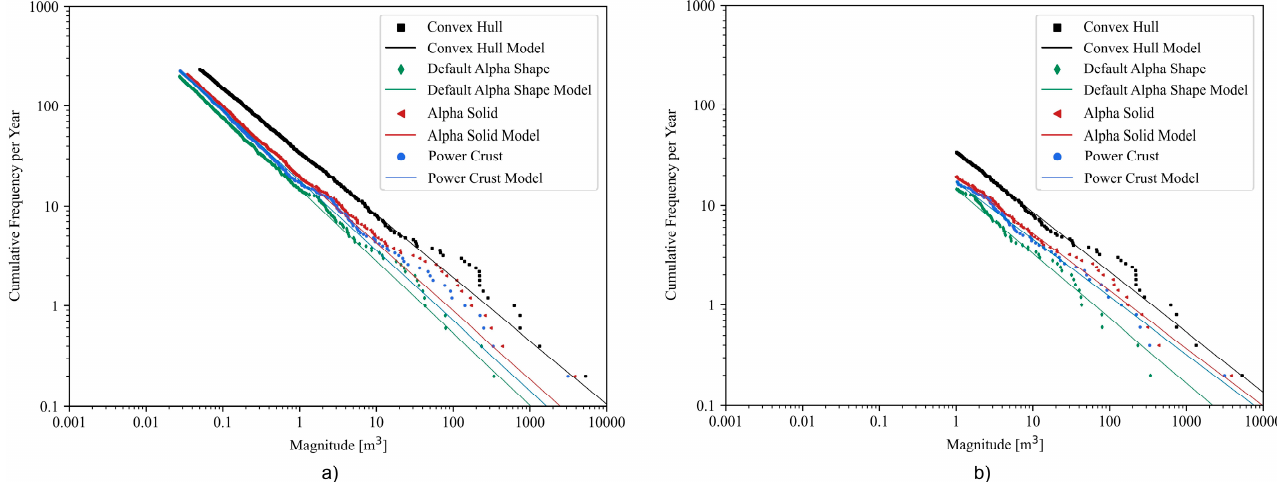
Figure 10. ( a ) the maximum likelihood estimation of power-law models, with the datasets truncated at their estimated values of x min found by minimizing the Kolmogorov–Smirnov statistic; ( b ) the maximum likelihood estimation of the power-law models, truncated at 1m 3 in order to better fit the tail-end of the distribution.